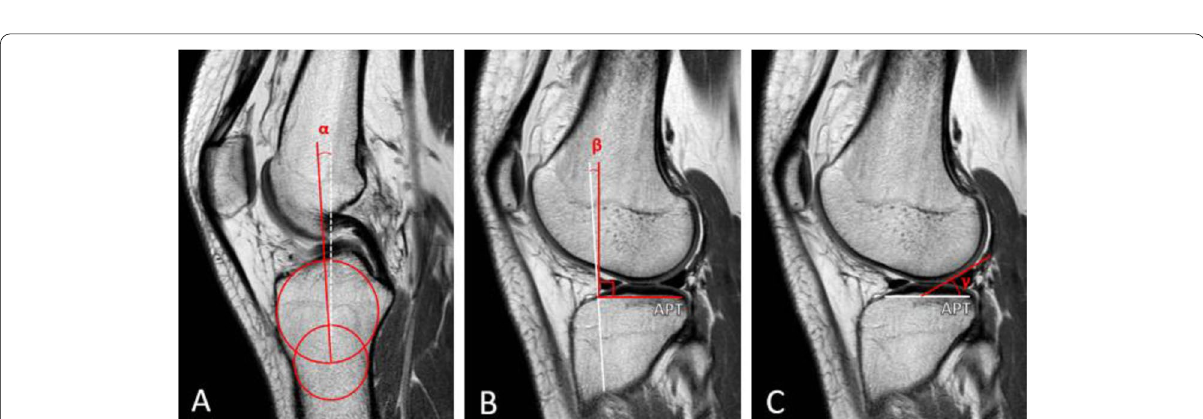
Fig. 1 Flow chart of patient in- and exclusion; “ACL Centre”